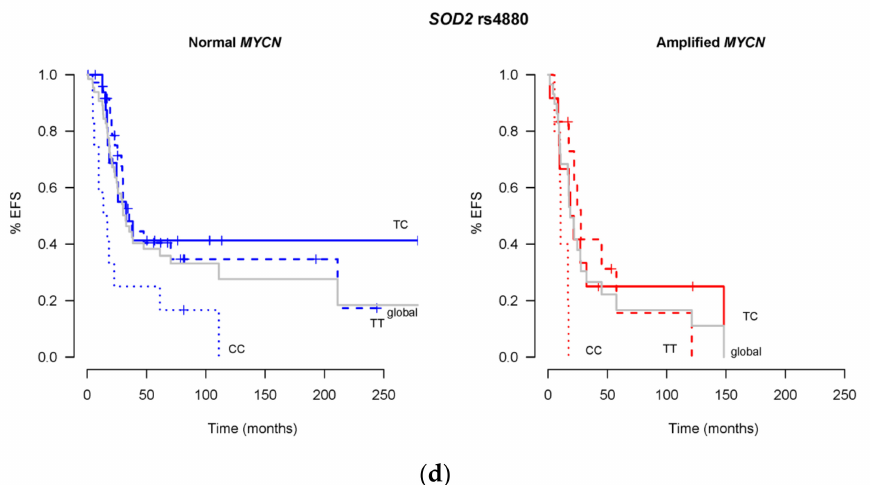
Figure 3. E ff ect of the addition of the EFS related SNPs, selected by Cox regression and Elastic Net, to the EFS prognosis e ff ect of MYCN status. The e ff ect of MYCN status alone (Normal, n = 66, on the left panels or Amplified, n = 29, on the right panels) is represented by the grey line named “global”, while the same patients’ data distributed according to the SNP variants, are represented by the colored lines. ( a ) Shows the results according to SNP variants in rs2032582 at ABCB1 gene, with no statistical significance comparing with the global lines. ( b ) Shows the results according to rs1544410 variants at VDR gene, with p = 0.027 for GA genotype, reaching statistically significant di ff erence comparing with the global lines. ( c ) Shows the results according to SNP variants in rs6539870 at a region with no identified gene, with GG genotype reaching p = 0.031 statistically significant di ff erence comparing with the global lines. ( d ) Shows the results according to rs4880 variants at SOD2 gene, with TC reaching p < 0.001 statistically significant di ff erence comparing with the global